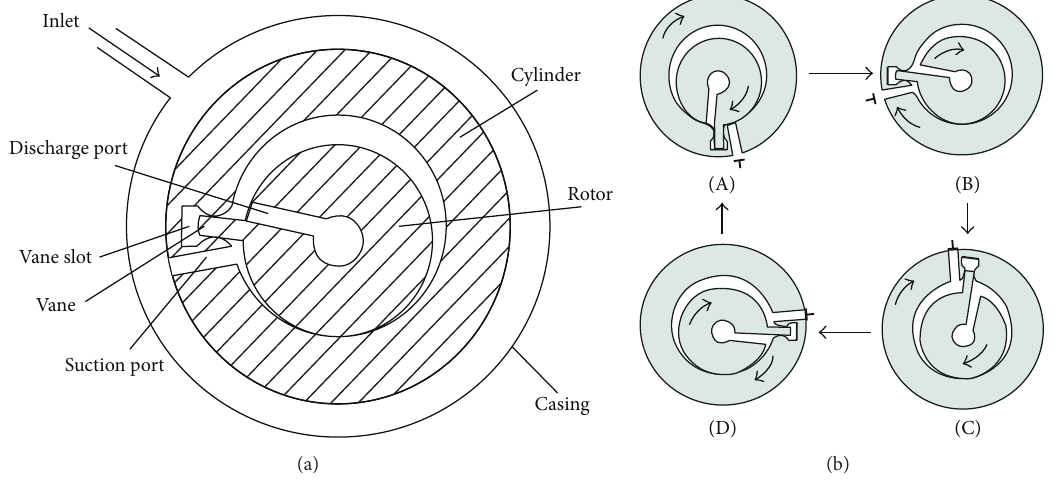
Figure 1: Revolving vane engine: (a) schematics and (b) working principles